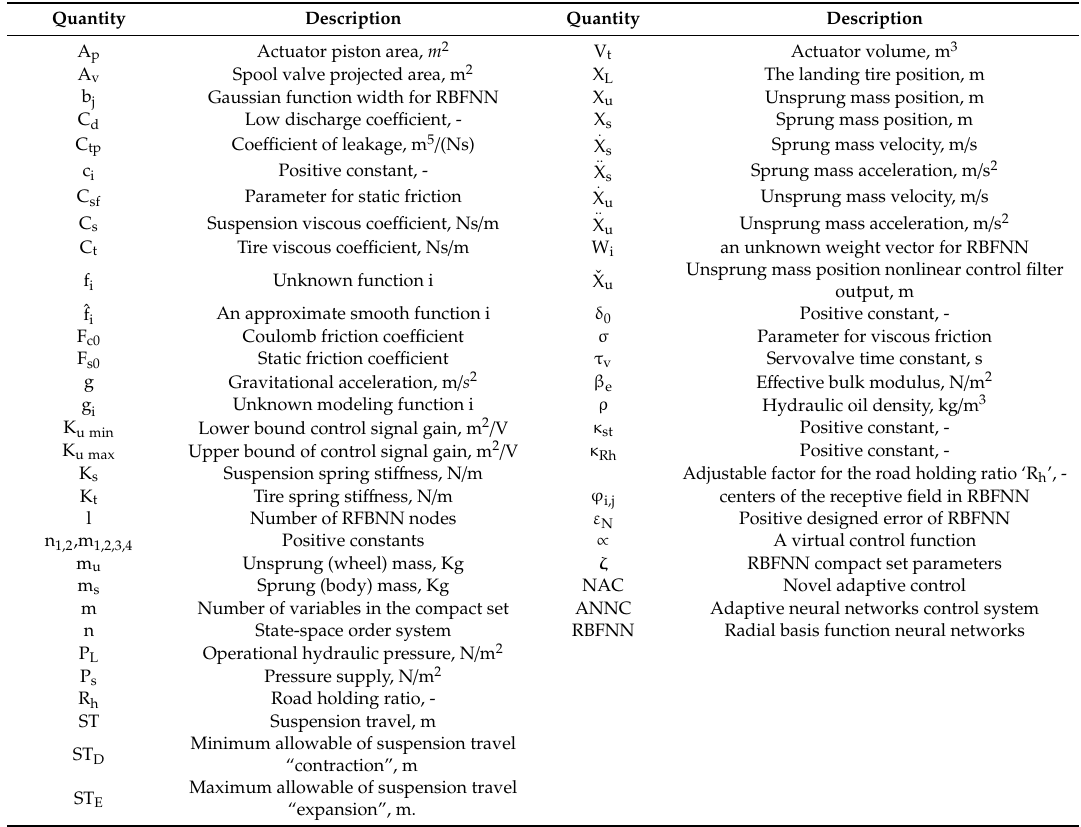
Table 1. Active suspension parameters and their